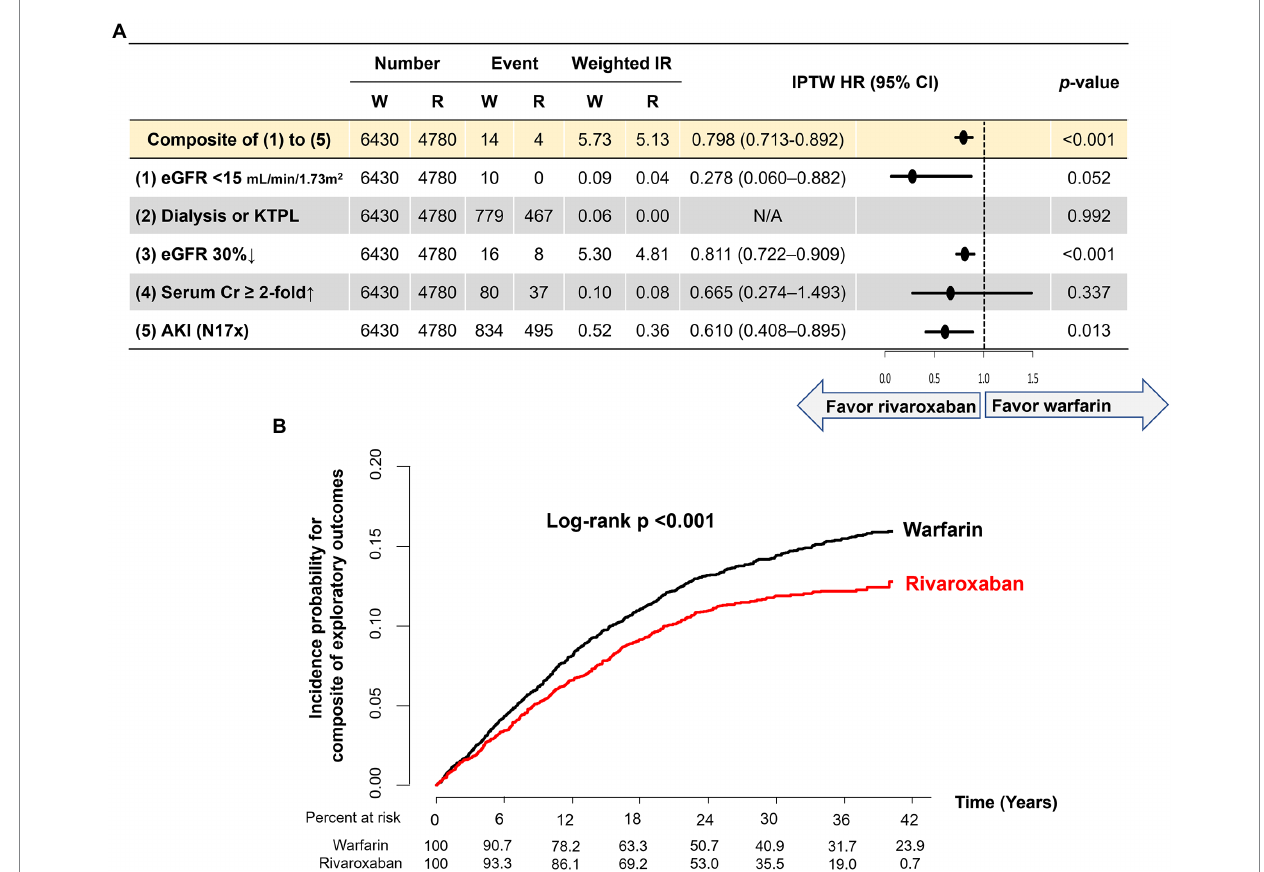
FIGURE 4 Exploratory analysis in patients with baseline and follow-up eGFR measurements. (A) . Weighted event numbers, incidence rates, and hazard ratios for five renal outcomes and composite of renal outcomes between rivaroxaban and warfarin groups (B) . Weighted Kaplan–Meier curves for the composite of renal outcomes between rivaroxaban and warfarin groups. Incidence rate, per 100 person-years. AKI, acute kidney injury; CI, confidence interval; Cr, creatinine; eGFR, estimated glomerular filtration rate; HR, hazard ratio; KTPL, kidney transplantation; IPTW, inverse probability of treatment weighting; IR, incidence rate; R, rivaroxaban; W,